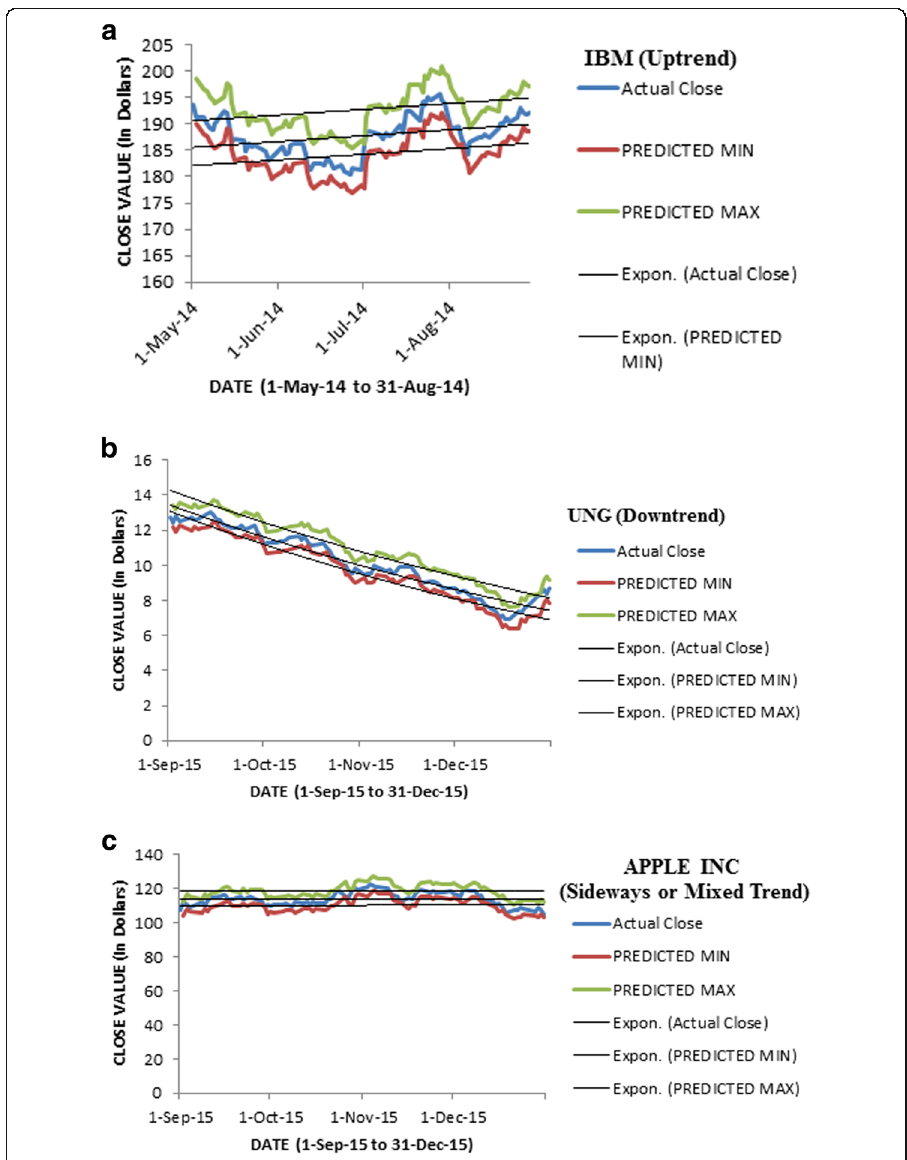
Fig. 2 Various stocks like: a IBM stock showing an uptrend b UNG stock showing a downtrend c APPLE INC stock showing a sideways or mixed trend using jump analysis